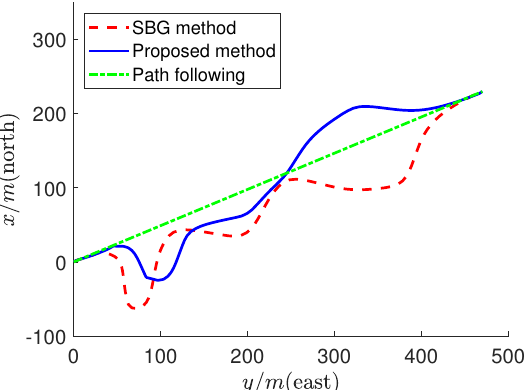
Figure 14. The changes of the ship domain dimensions for multiple obstacle avoidance.